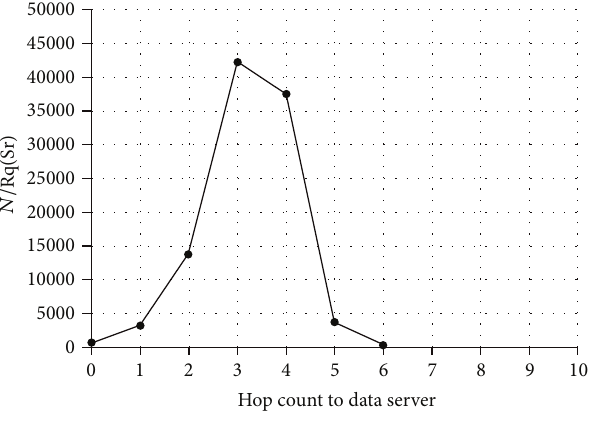
Figure 5: Dynamic adjacent list size (4) .